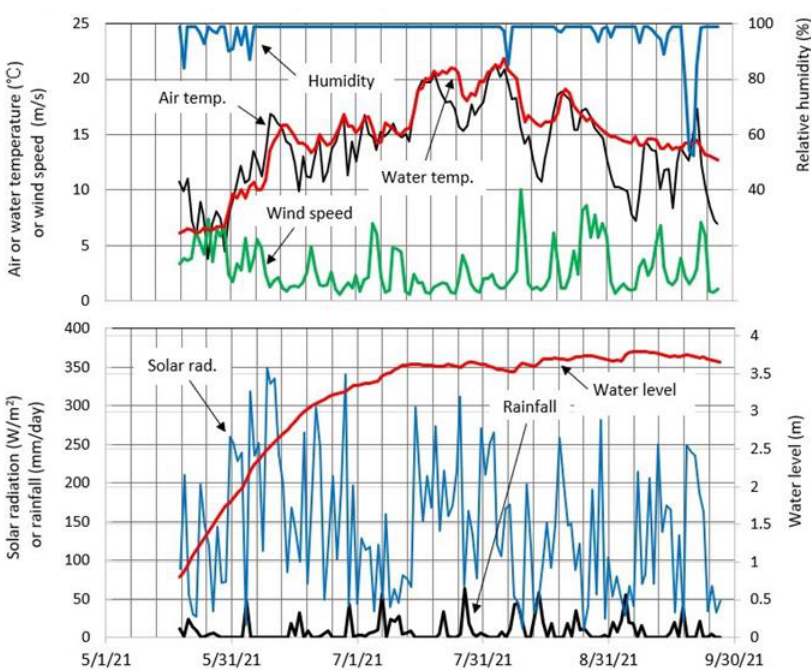
Figure 12. Temporal variations in daily mean air temperature, relative humidity, wind speed, solar radiation, lake level, 0.1-m depth water temperature, and diurnal rainfall for 19 May–27 September 2021.